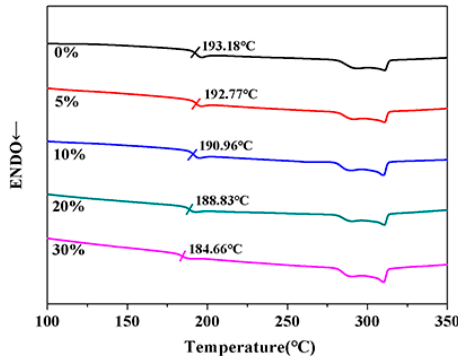
Figure 8. Dielectric constant ( a ) and dielectric loss of BT@ZnPc-2/PEN films with the changing of frequency.